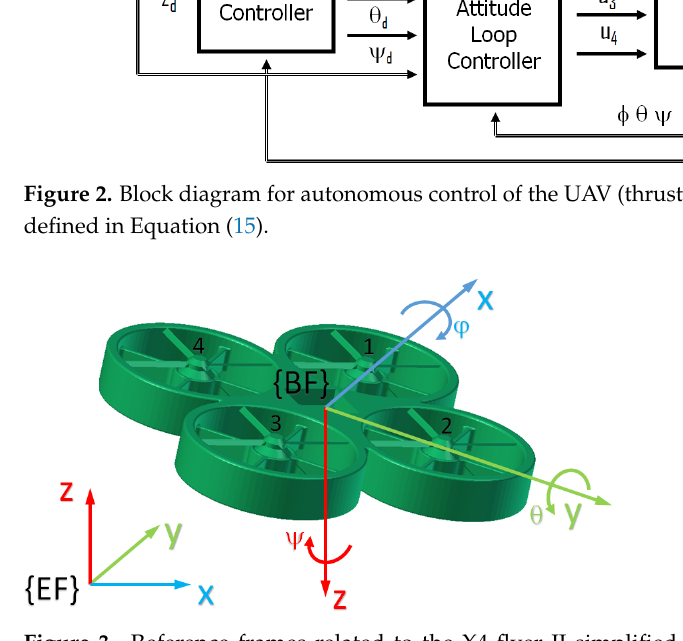
Figure 3. Reference frames related to the X4-flyer II simplified graphics. Left (4) and right (2) propulsion units rotate clockwise, while the front (1) and rear (3)